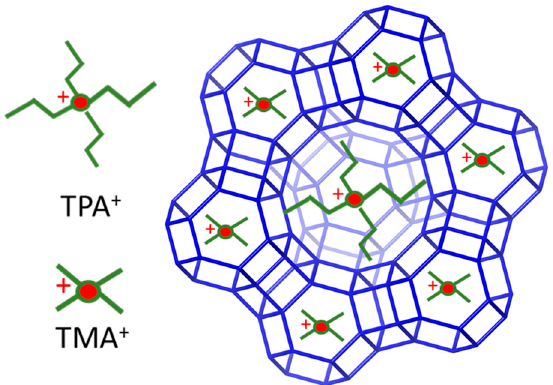
Figure 6. SAPO-37 synthesis using the co-templating technique: formation of the supercage using larger TPA + molecules and sodalite cage using smaller TMA + molecules (SAPO-37 image is produced by 3D drawing tool in database of zeolites structures, Accessed 17 March 2022) [78].